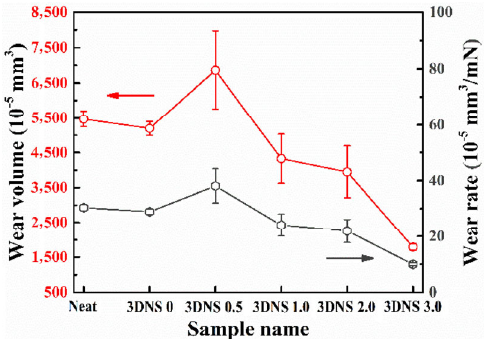
Fig. 8 Wear rate and wear volumes of epoxy resin and epoxy– Ti 3 C 2 3DNS